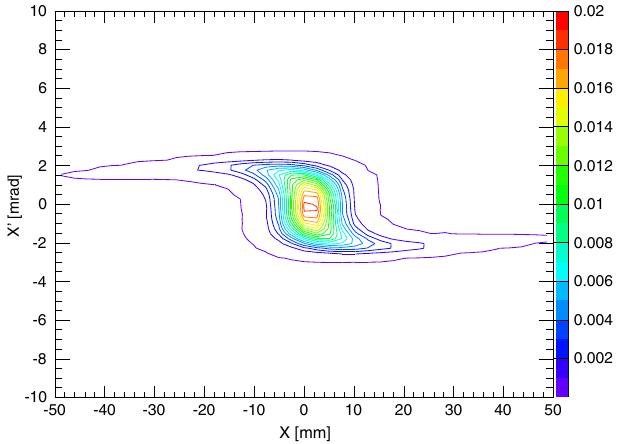
FIG. 19. Contour plot of transverse phase space distribution in the horizontal direction for beam injected into the muon pro- duction target.